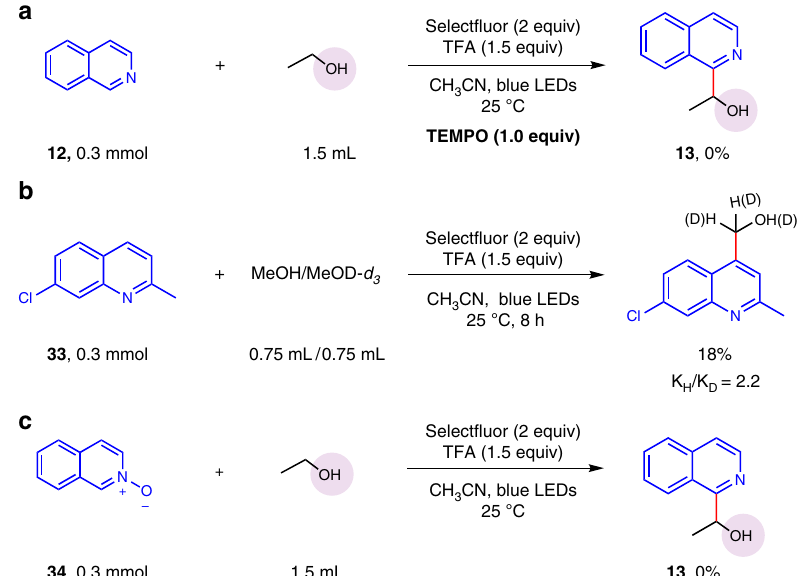
Fig. 7 Mechanistic studies. a Radical inhibition experiment. b Intermolecular kinetic isotope effect experiment. c The intermediates